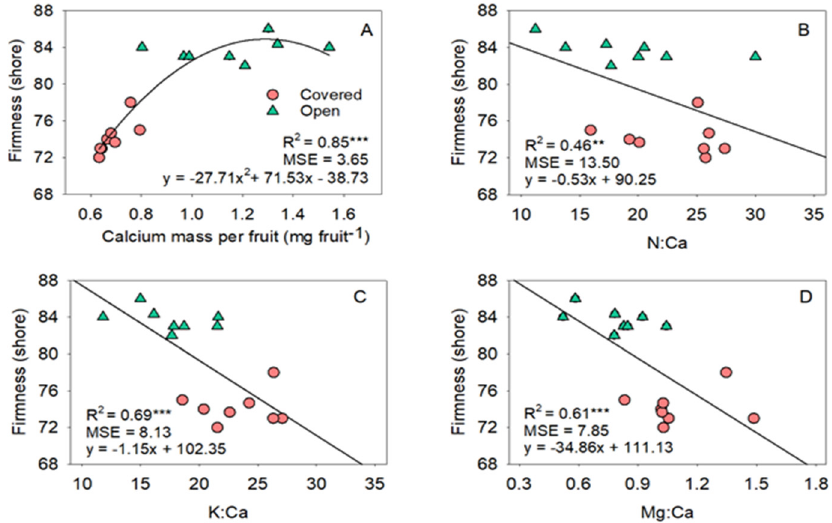
Figure 3. Relationship between fruit firmness and Ca mass per fruit ( A ), N:Ca ( B ), K:Ca ( C ), and Mg:Ca ( D ) for ‘Santina’ sweet cherries grown inside and outside high tunnels in the Central Valley of Chile. Plot 2, season 2019/2020. ** and *** correspond to the p -values ≤ 0.01 and 0.001; MSE: mean square